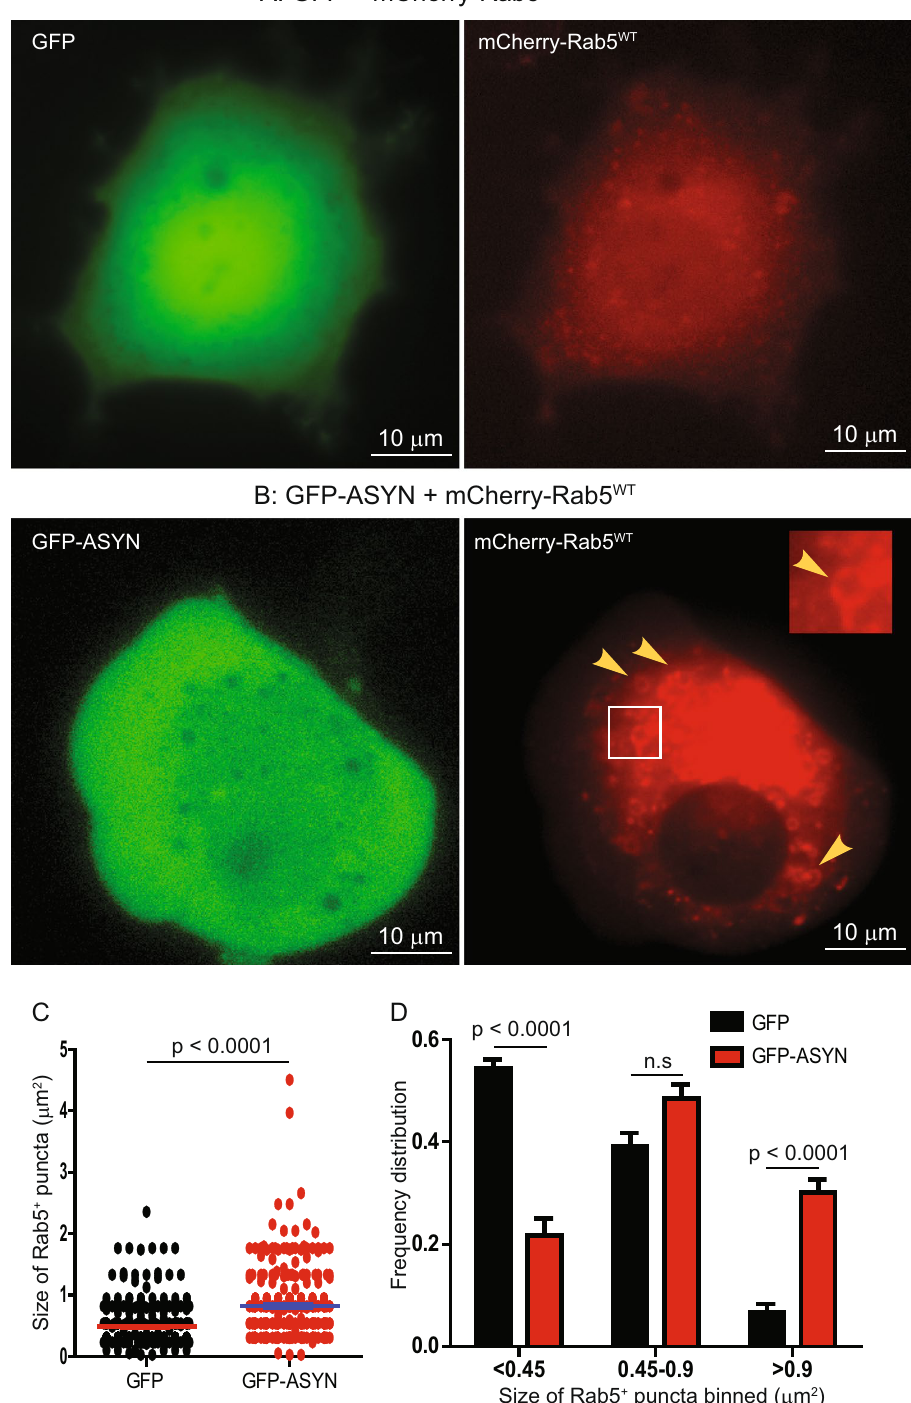
<0.45 Figure 4. Expression of GFP-ASYN induced enlargement of Rab5 early endosomes in PC12 cells. PC12 cells were transfected with either GFP + mCherry-Rab5 WT ( A ) or GFP-ASYN + mCherry-Rab5 WT ( B ) for 48 hrs. Enlarged mCherry-Rab5 early endosomes typically seen in GFP-ASYN cells were indicated with arrow heads ( B ). The size of mCherry-Rab5 in A and B was quantitated and presented in C; and the size distribution of the mCherry-Rab5 early endosomes was presented in D . The p values are indicated and n.s. =